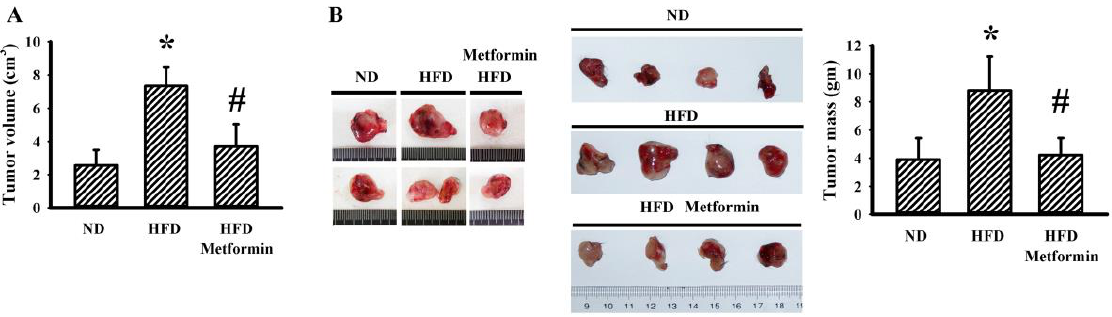
(Figure 3D), TGF- β 1 (Figure 3E) and HMGB1 (Figure 3F). Metformin mitigated all changes in tumor-bearing HFD-fed obese mice, with the exception of glutamine, where metformin caused an additional elevation of glutamine (Figures 2 and 3). These findings indicate that the tumor growth inhibitory effect of metformin is accompanied by improved metabolic and pro-inflammatory alterations in tumor-bearing HFD-fed obese mice.